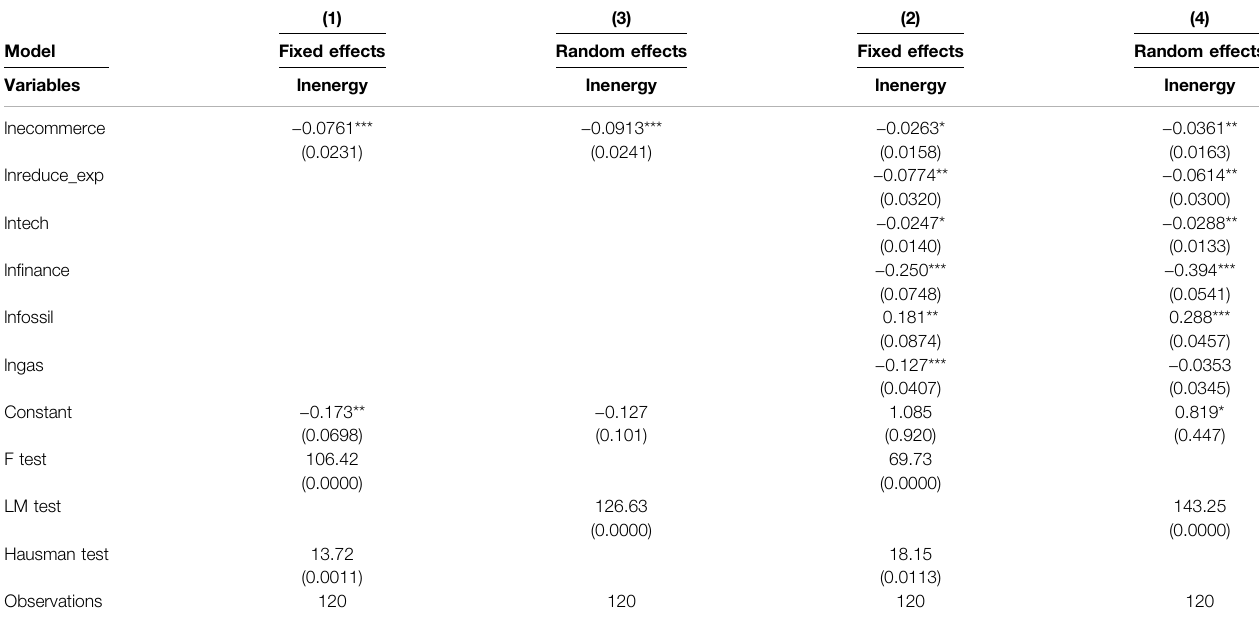
TABLE 5 | Panel regression model analysis